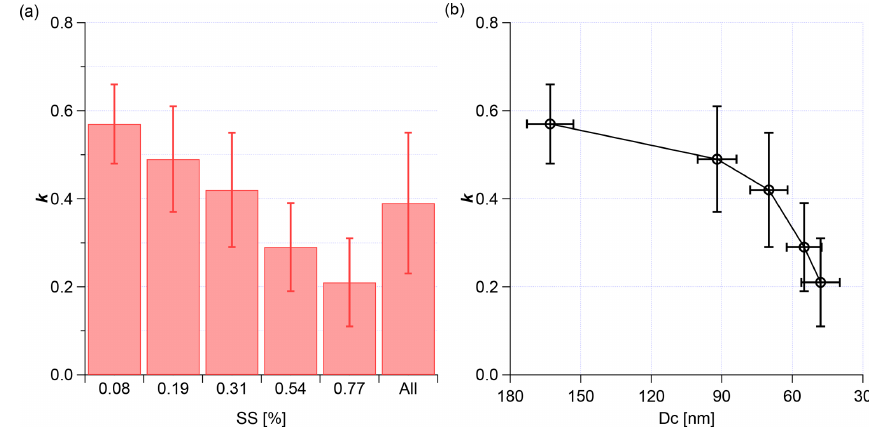
Figure 9. (a) Derived κ values at different supersaturations. (b) κ values as a function of the corresponding d crit . Error bar represents the 1 standard deviation.